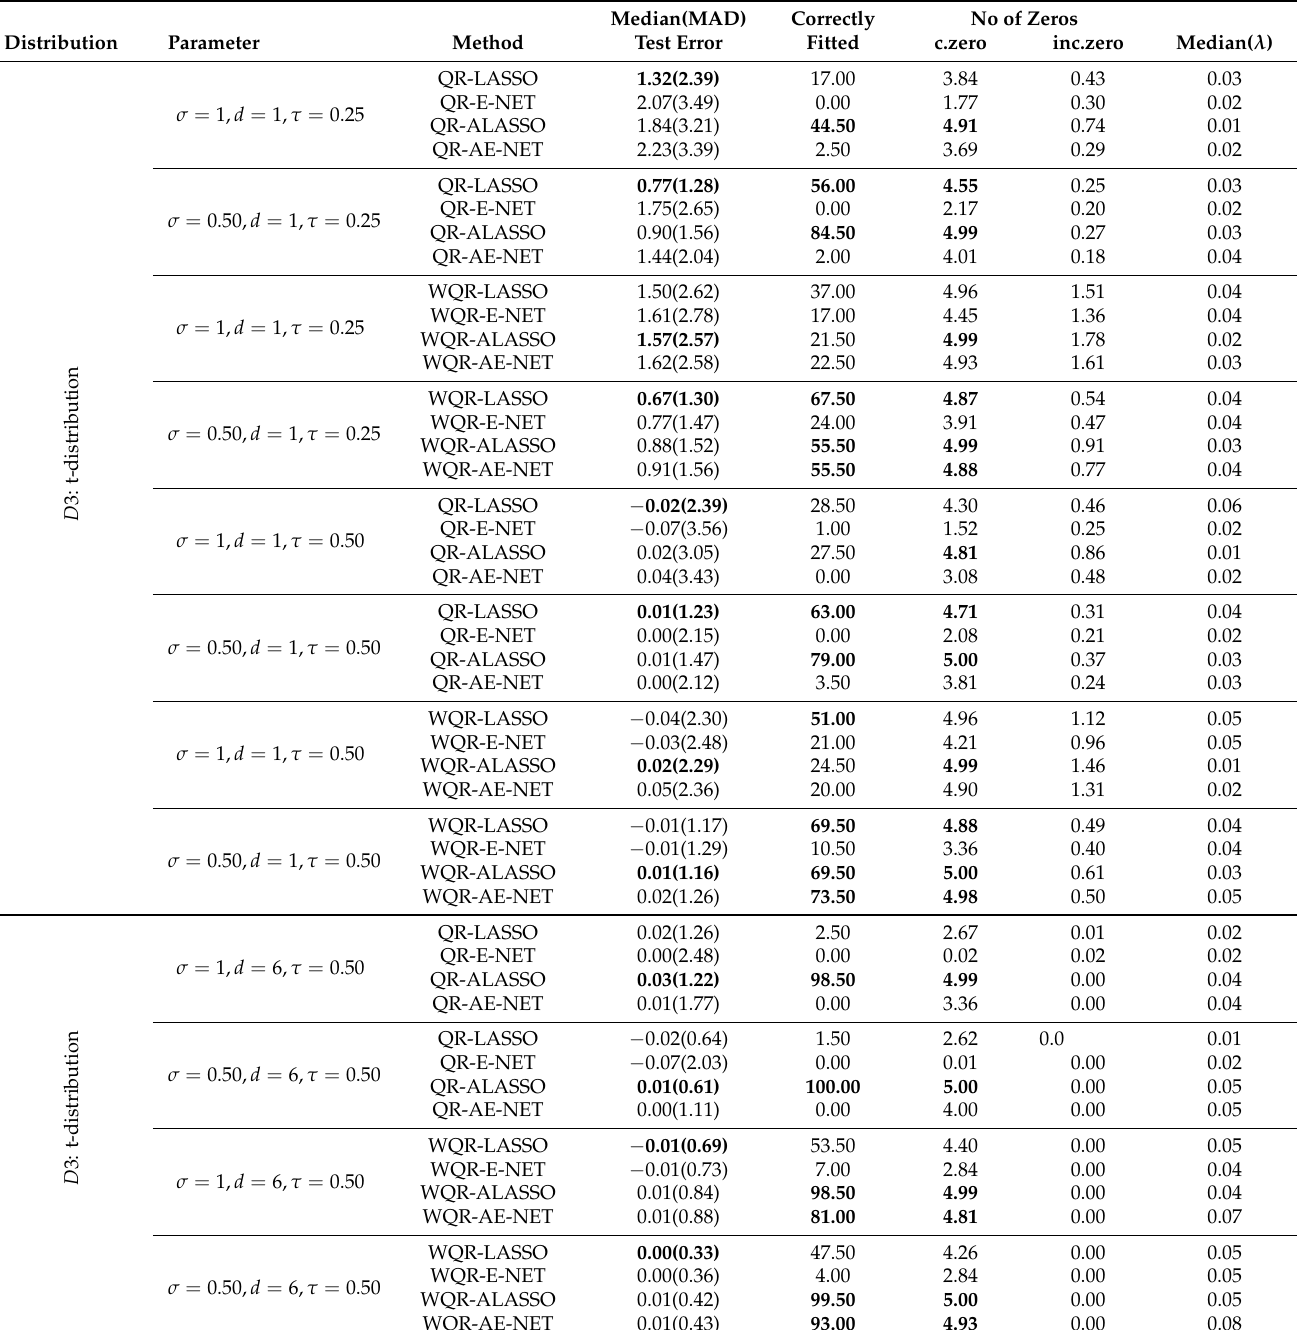
Table 5. Penalized weighted and unweighted quantile regression at D 3 for n = 50 ( τ = 0.25 and τ = 0.50) under the heavy tailed t-distribution; bold text indicate superior